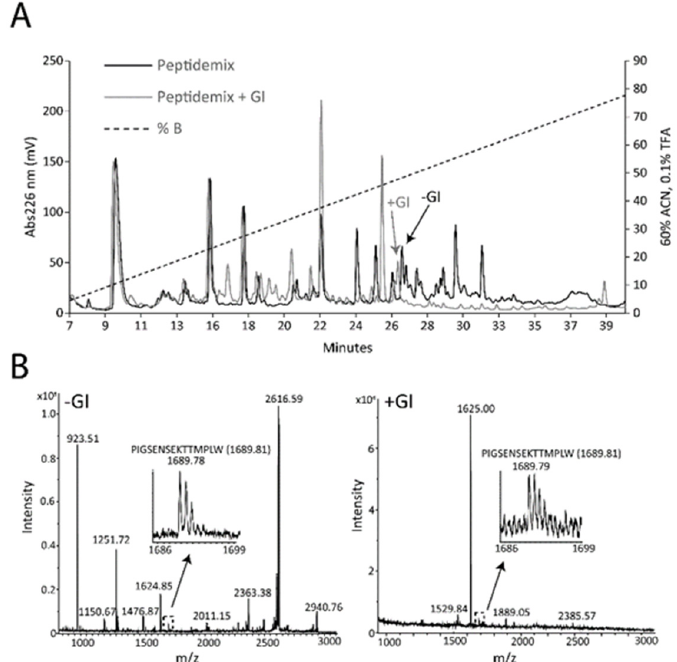
Figure 4. In vitro gastrointestinal digestion (GI) of milk peptides. Milk peptides were incubated with pepsin and then trypsin, chymotrypsin and elastase. ( A ) The peptides were separated by RP-HPLC, eluted with a gradient of 60% acetonitrile (ACN) in 0.1% trifluoroacetic acid (TFA) (dashed line) and detected by measuring the absorbance at 226 nm (solid line). ( B ) All fractions were analyzed by MALDI-MS and representative data from two fractions before and after GI digestion are shown. Both fractions contained the 185 PIGSENSEKTTMPLW 199 peptide.